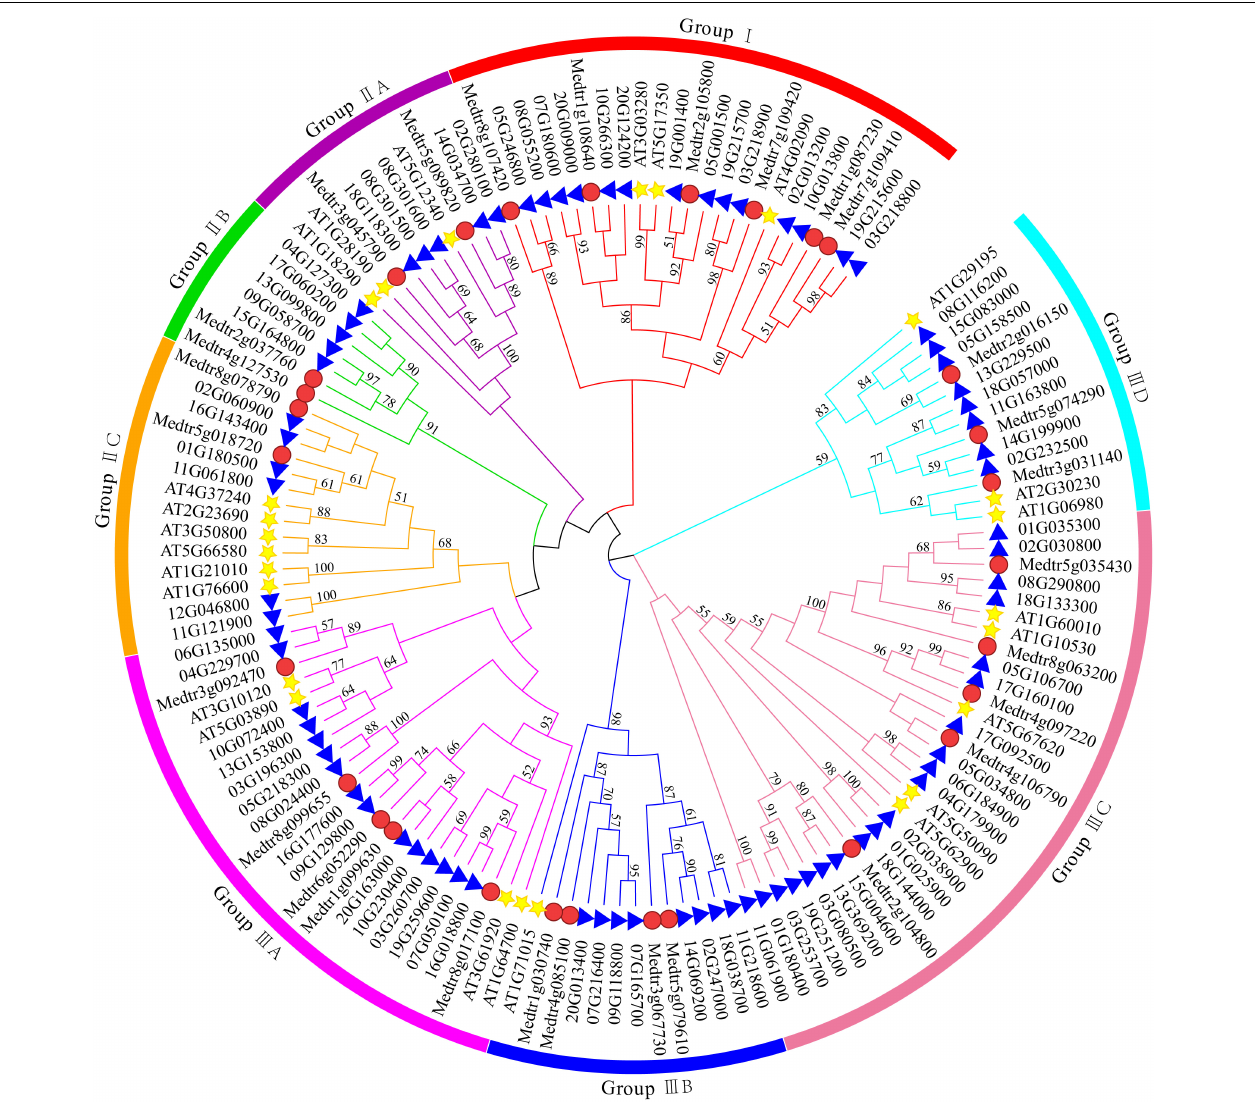
FIGURE 1 | Phylogenetic tree of DUF4228 proteins from Arabidopsis , Medicago truncatula , and soybean using the ML method. The colored arcs indicate different groups. The stars, circles, and triangles represent proteins of Arabidopsis Medicago truncatula , and soybean,